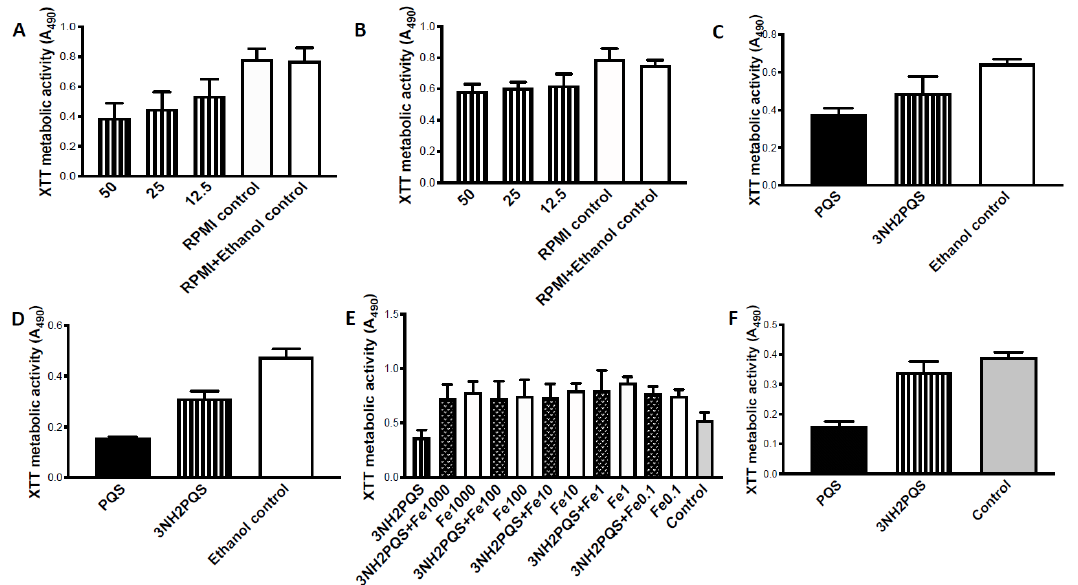
Figure 3. Studies with 3NH 2 -PQS. ( A ) Dose-response study with preformed 10AF biofilm. Minimal dose-response. “RPMI control” was biofilm without test article or diluent, “RPMI + Ethanol control” contained same concentration of ethanol diluent as present in test article wells; no difference between these controls. Both controls were also included in sections ( B ) through ( D ) of Figure 3, but as the results of these two controls was always the same, for simplification, only one control is shown in sections ( C ) through ( F ). Twofold dilutions of 3NH 2 -PQS were made from 50 to 0.78 µ g/mL. Only at the very highest doses (12.5–50 µ g/mL, shown) was there a suggestion of dose response, but there was no statistically significant difference among those bars. 3NH 2 -PQS at 0.78 µ g/mL was not different from controls shown, and bars showing results with 1.56–6.25 µ g/mL were not different from that of 12.5 µ g/mL, so are not shown in order to simplify the figure.